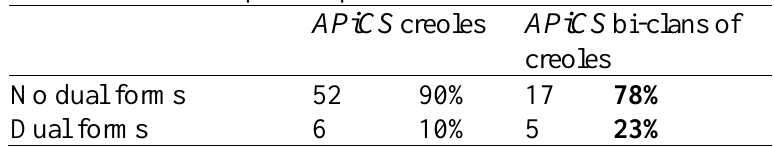
Table 6. Duals in independent